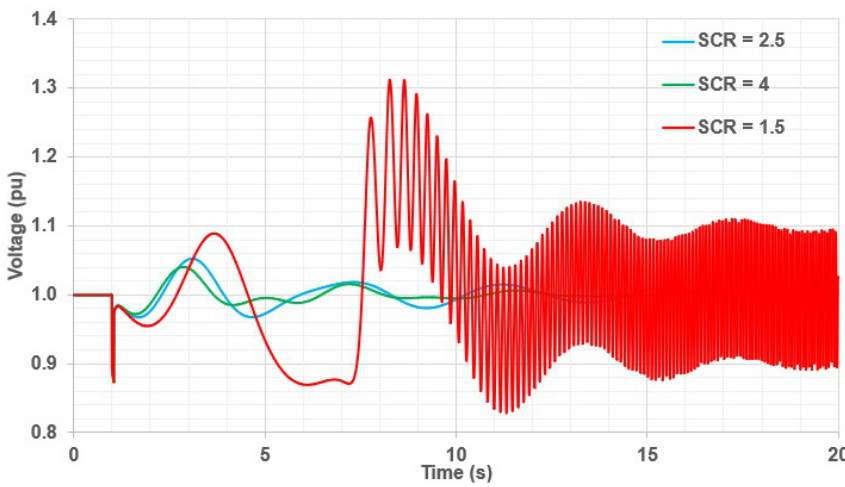
Figure 21. Generation source terminal voltage under different